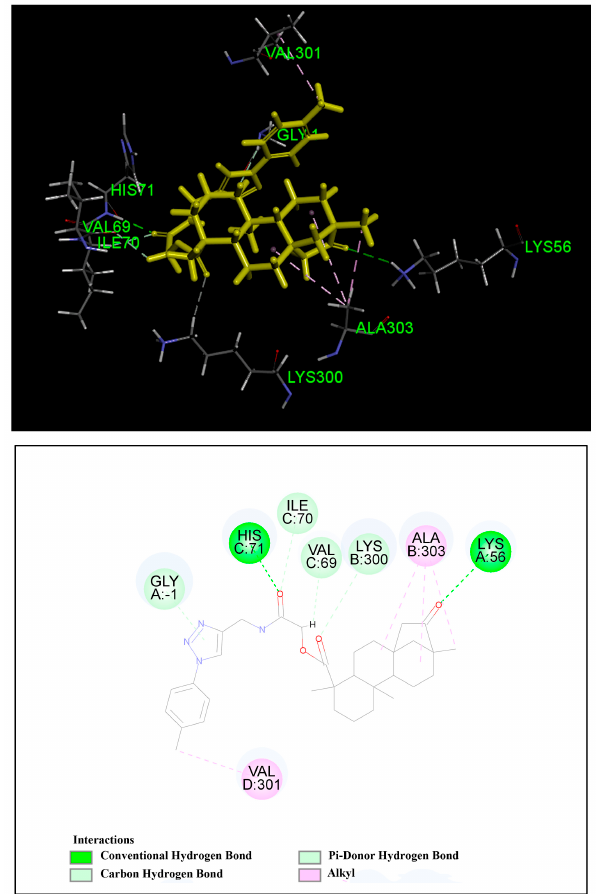
Figure 6. Computer modelling of compound 5d binding to CDK2/cyclin A (3my5). Compound 5d was colored in yellow.